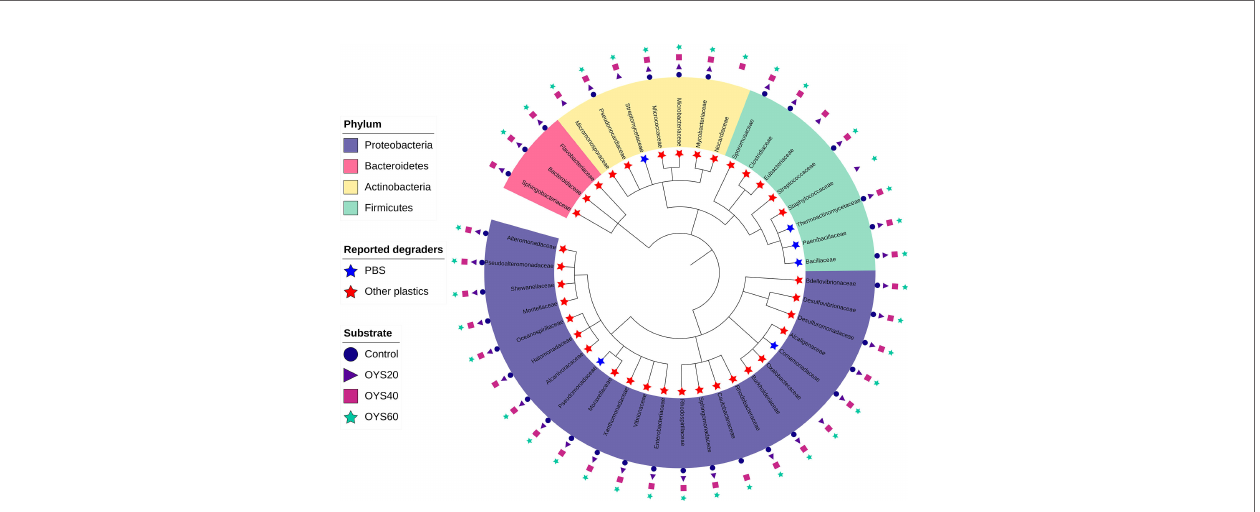
FIGURE 6 | Phylogenetic tree representing all bacterial families detected in this study which previously have been identi fi ed as having potential plastic-degrading capabilities. The taxa with reports of plastic degradation were identi fi ed using the PlasticDB web server (http://www.plasticdb.org/), and the phylogenetic relationship among the shown taxa was extracted from the NCBI taxonomic database (Schoch et al., 2020). Leaves are colored according to their corresponding phyla. Blue stars represent bacterial families reported to degrade polybutylene succinate (PBS), red stars represent bacterial families reported to degrade other plastics. Icons highlighted on the rings external to the tree represent the substrates associated with bacterial families with plastic-degrading